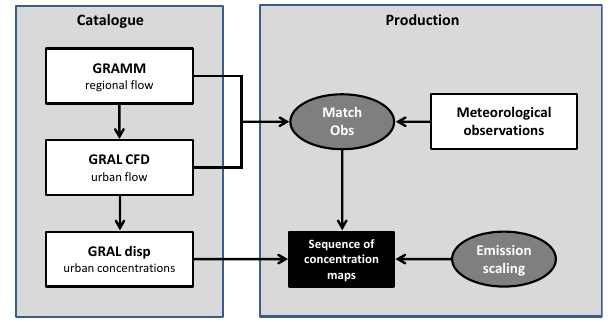
Figure 1. Scheme of the multi-step procedure to generate a se- quence of hourly steady-state concentration maps from a catalogue of pre-computed wind and concentration fields. The dark grey ovals are the method steps for generating time series of concentrations from the catalogue. Light grey rectangles denote intermediary prod- ucts and inputs in the